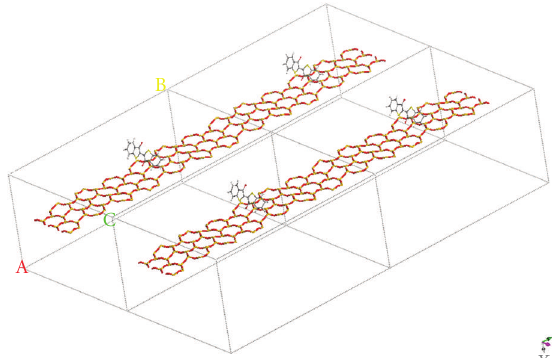
Figure 6: Periodic structure of sepiolite/thioindigo complex used for CASTEP